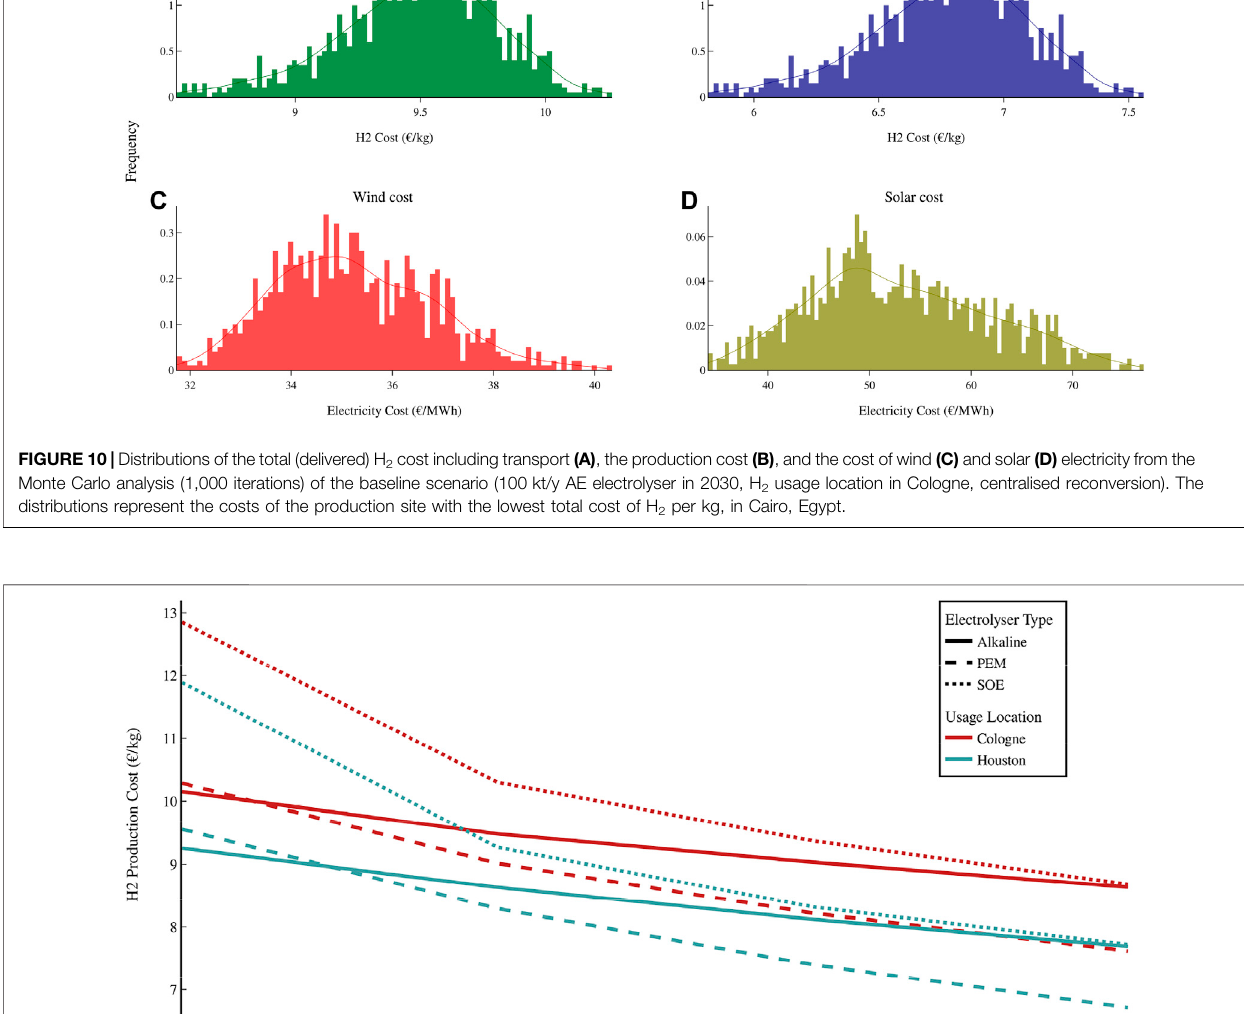
Frontiers in Energy Research |